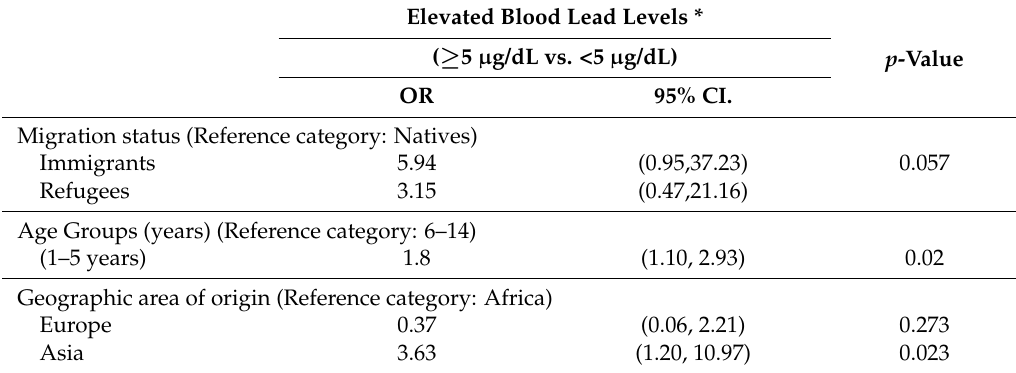
Table 3. Multiple logistic regression derived odds ratios (and 95% confidence intervals) for the risk factors for elevated blood lead levels